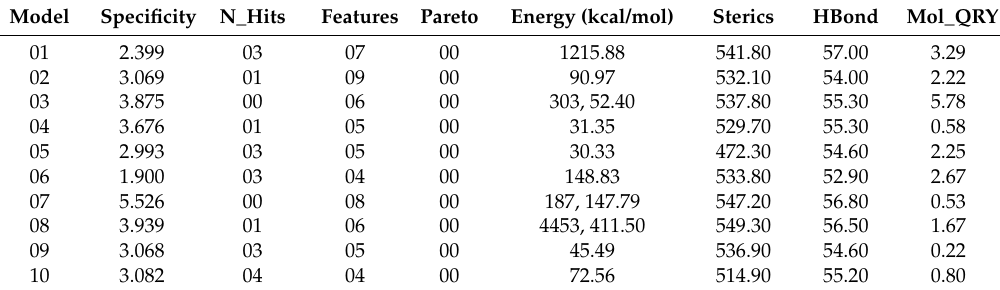
Table 1. Features of each pharmacophoric model generated using GALAHAD.